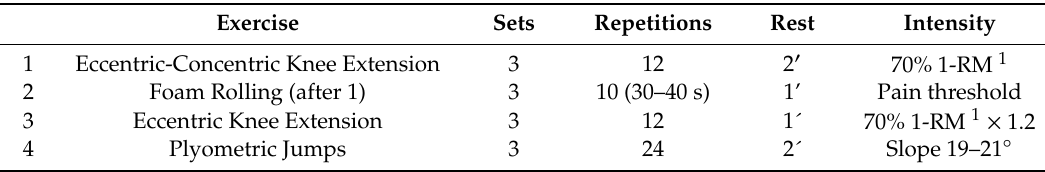
Table 3. Characteristics of the exercise stimuli